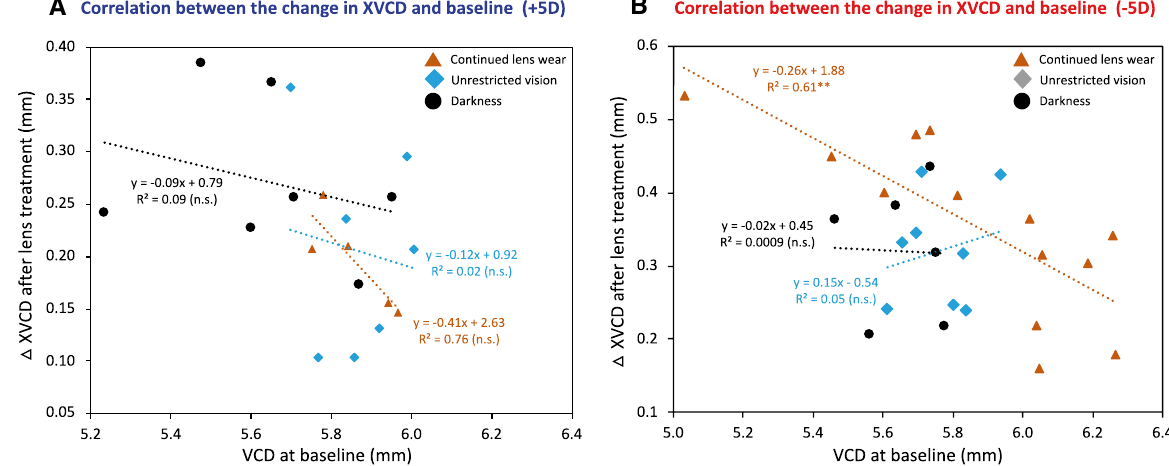
Figure 7. Changes in vitreous chamber depth (VCD) as a function of the baseline measurement for animals wearing + 5D ( A ) and − 5D ( B ) lenses. n.s. Not significant; **p <